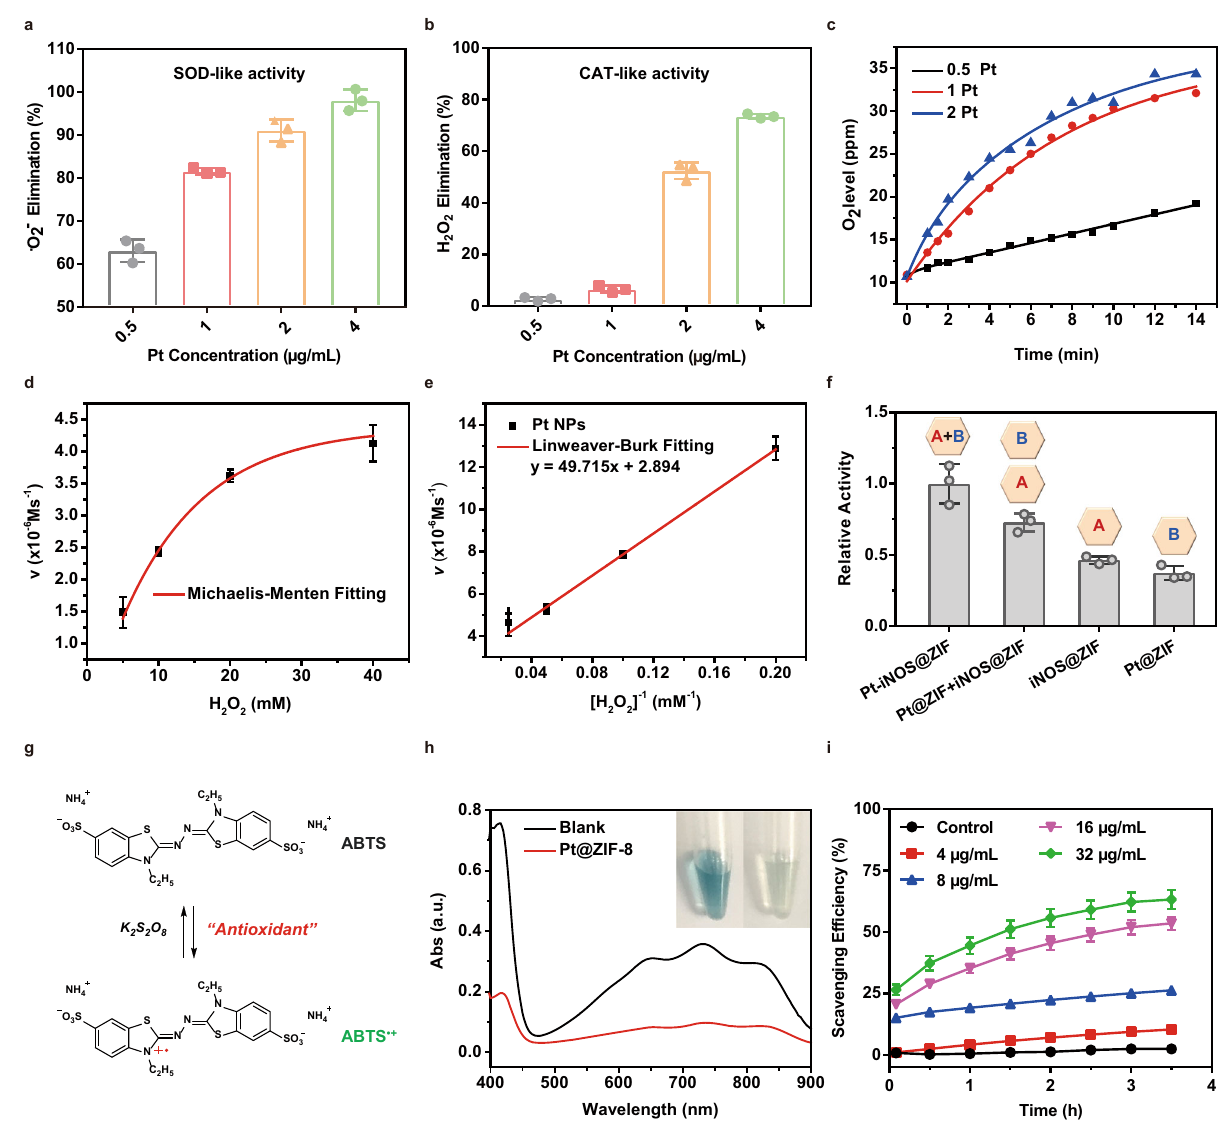
Fig. 3 In vitro catalytic performance. a , b ROS scavenging activities of Pt NPs with SOD-like and CAT-like properties. c Concentration-dependent generation of O 2 in the presence of Pt nanozyme at different concentrations (0.5, 1.0 and 2.0 µ g/mL). d , e Michaelis-Menten steady-state kinetics of O 2 generation from the decomposition of H 2 O 2 by Pt NPs. f The normalized enzymatic activities of Pt-iNOS@ZIF, Pt@ZIF + iNOS@ZIF, iNOS@ZIF and Pt@ZIF at 12 h time point. The inside symbol [A] = iNOS, [B] = Pt. g The antioxidant principle of the ABTS assay. h Absorbance and pictures of ABTS radicals with or without treatment of Pt-iNOS@ZIF at 3 h time point. i Analysis of the scavenging ef fi ciency of ABTS radicals by different concentrations of